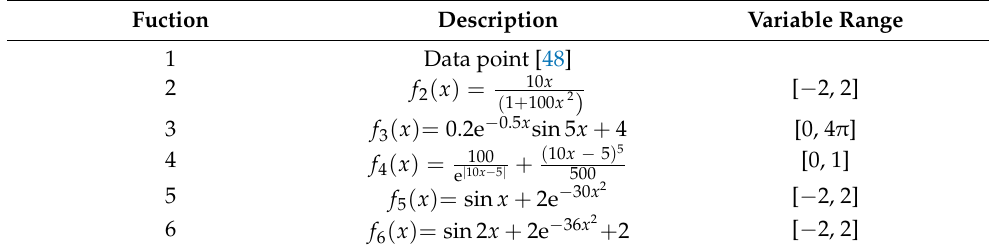
Table 2. Test six models mentioned in the literature. (Adapted with permission from Ref. [19]). Fuction